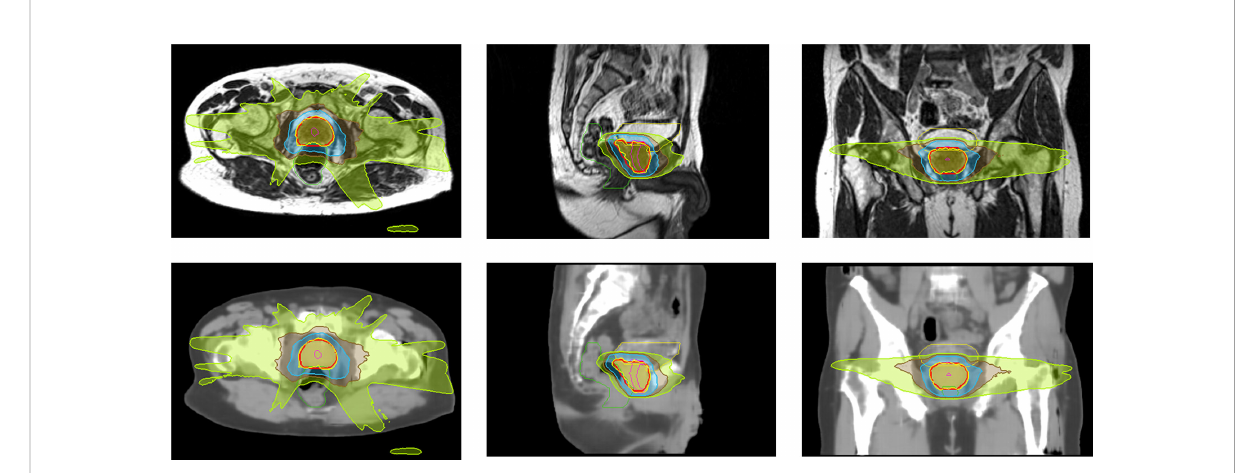
FIGURE 4 Isodose color wash (100%, 69%, 50% and 30% of 36.25 Gy in the prescribed dose) displayed on MR and sCT ave images in axial, sagittal and coronal views for the worst